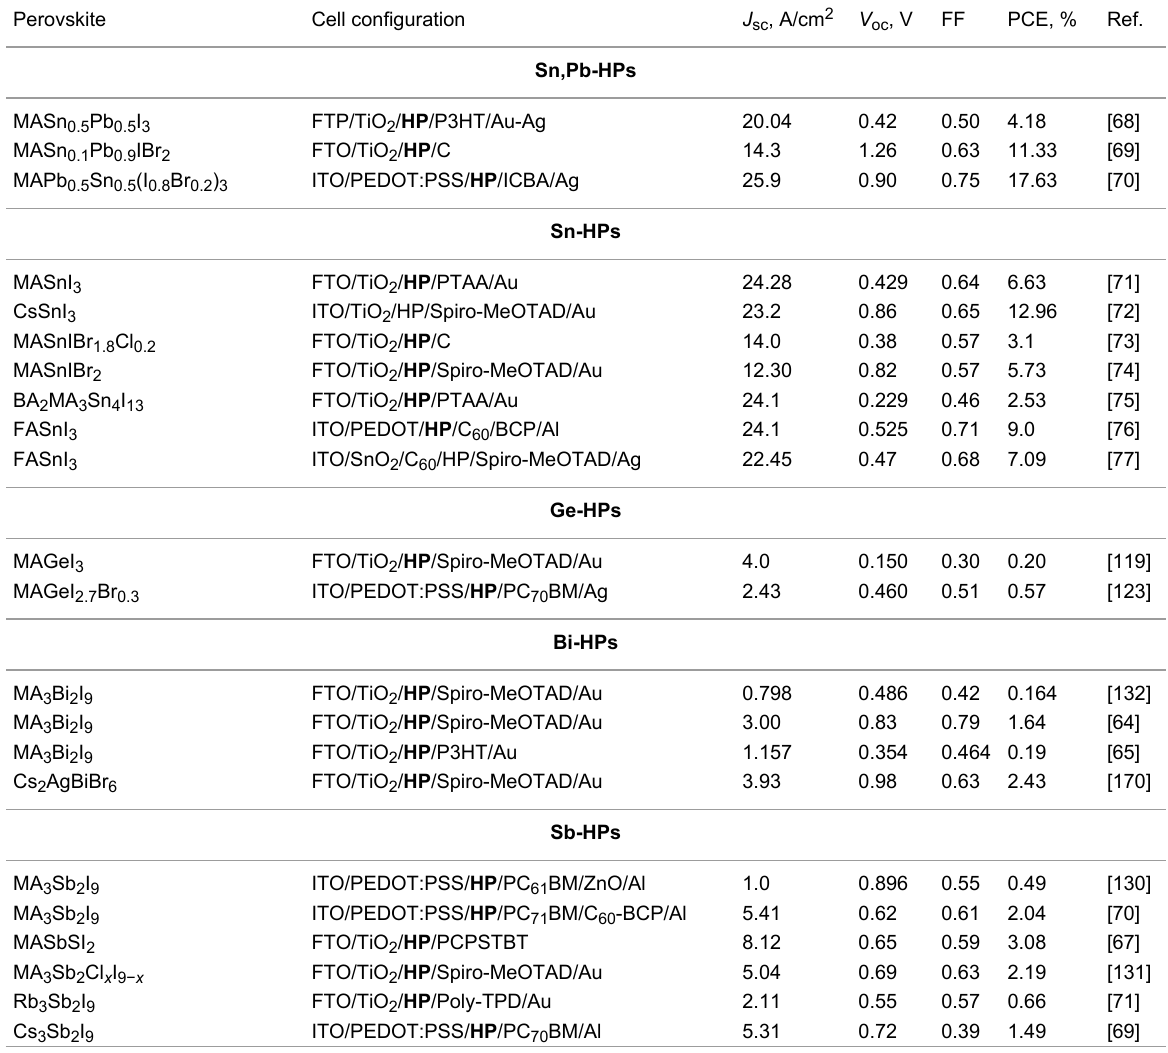
Table 1: Photovoltaic characteristics of selected mixed and lead-free HP-based solar cells. a